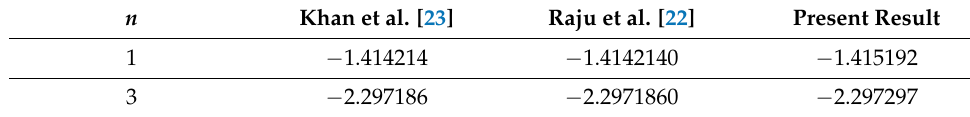
Table 3. Comparison of the model for g (cid:48)(cid:48) ( 0 ) in the absence of φ &